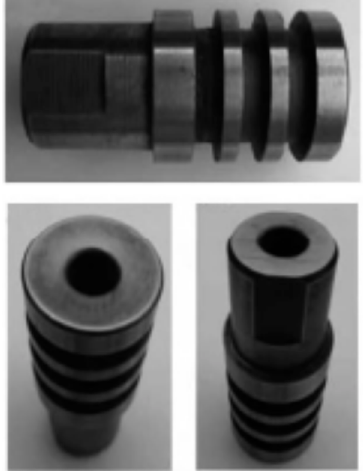
Figure 5. A novel hollow pin-less tool. (Reprinted with permission from [49]. Copyright 2013 Transactions of The China Welding Institution).